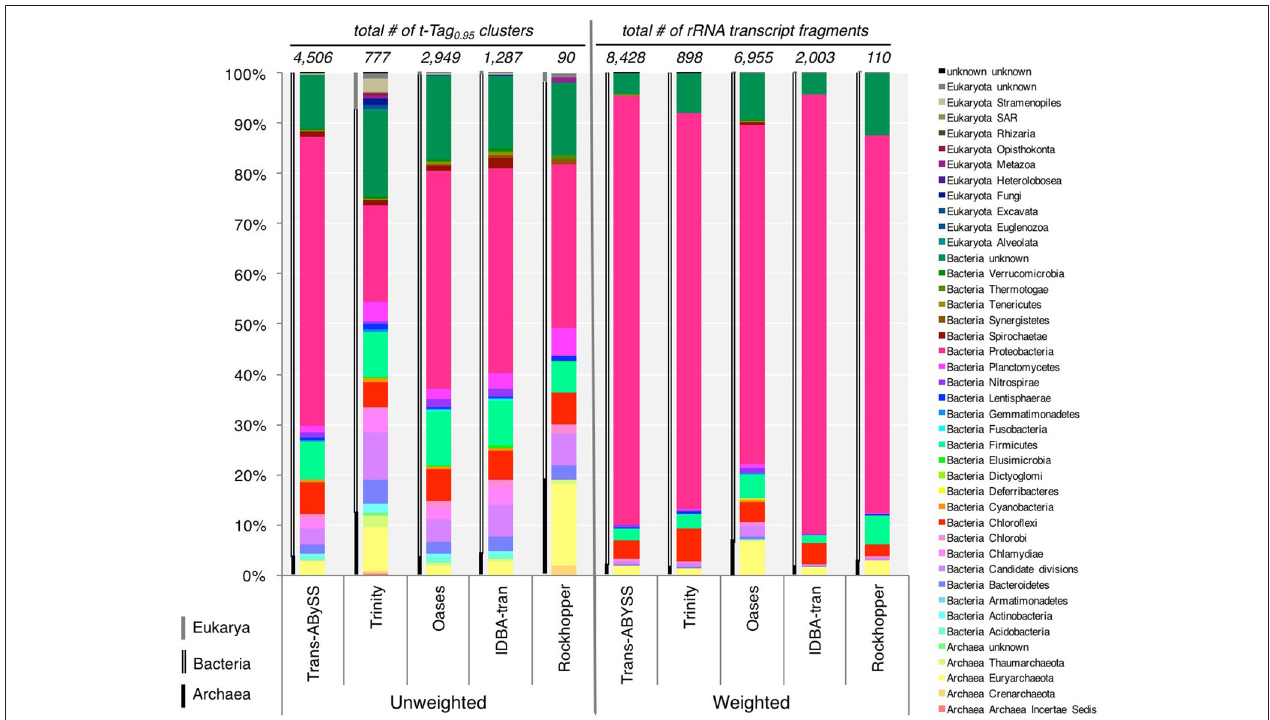
FIGURE 7 | Unweighted and weighted taxonomic compositions revealed by five de novo assemblers. For unweighted diversity, distribution of phyla was estimated from the number of the small and large subunits of ribosomal RNA (rRNA) transcripts; whereas coverage, read counts normalized to corresponding transcript length, was used to determine the weighted diversity. The classification of Eukaryota in the database is not as clearly defined as those of Archaea and Bacteria, so taxonomic level immediately below the Domain Eukaryota was taken as “phyla.” Archaeal, bacterial and eukaryal phyla are indicated, respectively, by single black line, double black lines and single gray line to the left of each bar graph. The data is provided in Table S2.